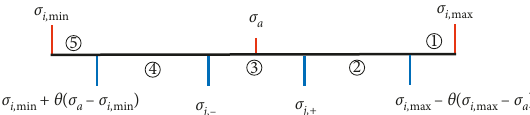
Figure 2: Characteristic stress points and stress partitions.